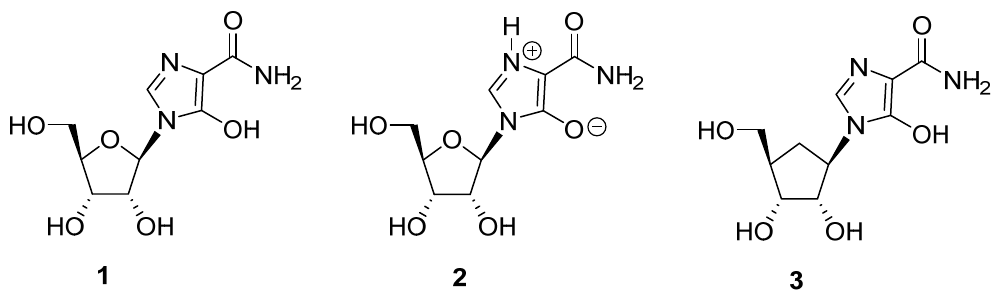
Figure 1. Structure of bredinin 1 , its zwitterionic form 2 [6] and its carbocyclic analog 3